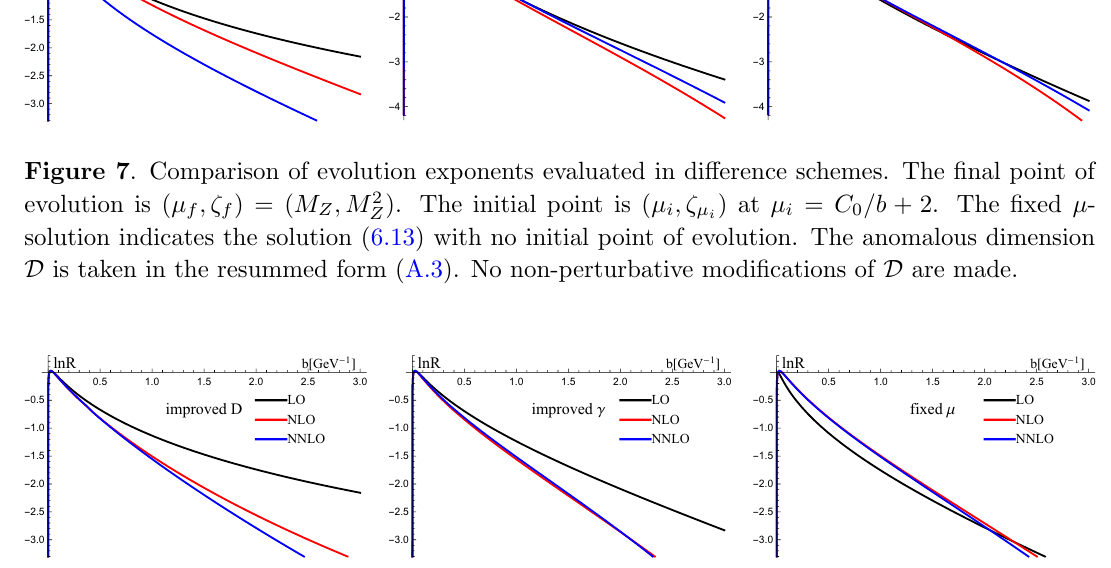
Figure 8 . Comparison of evolution exponents evaluated at di(cid:11)erent orders. All inputs are the same as in (cid:12)gure 7.